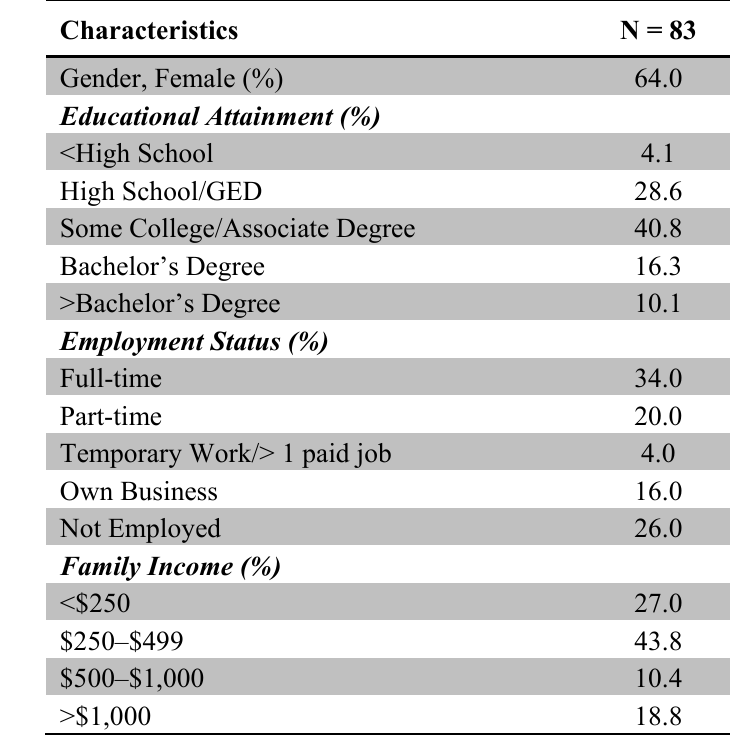
Table 2. Socio-demographic Characteristics of